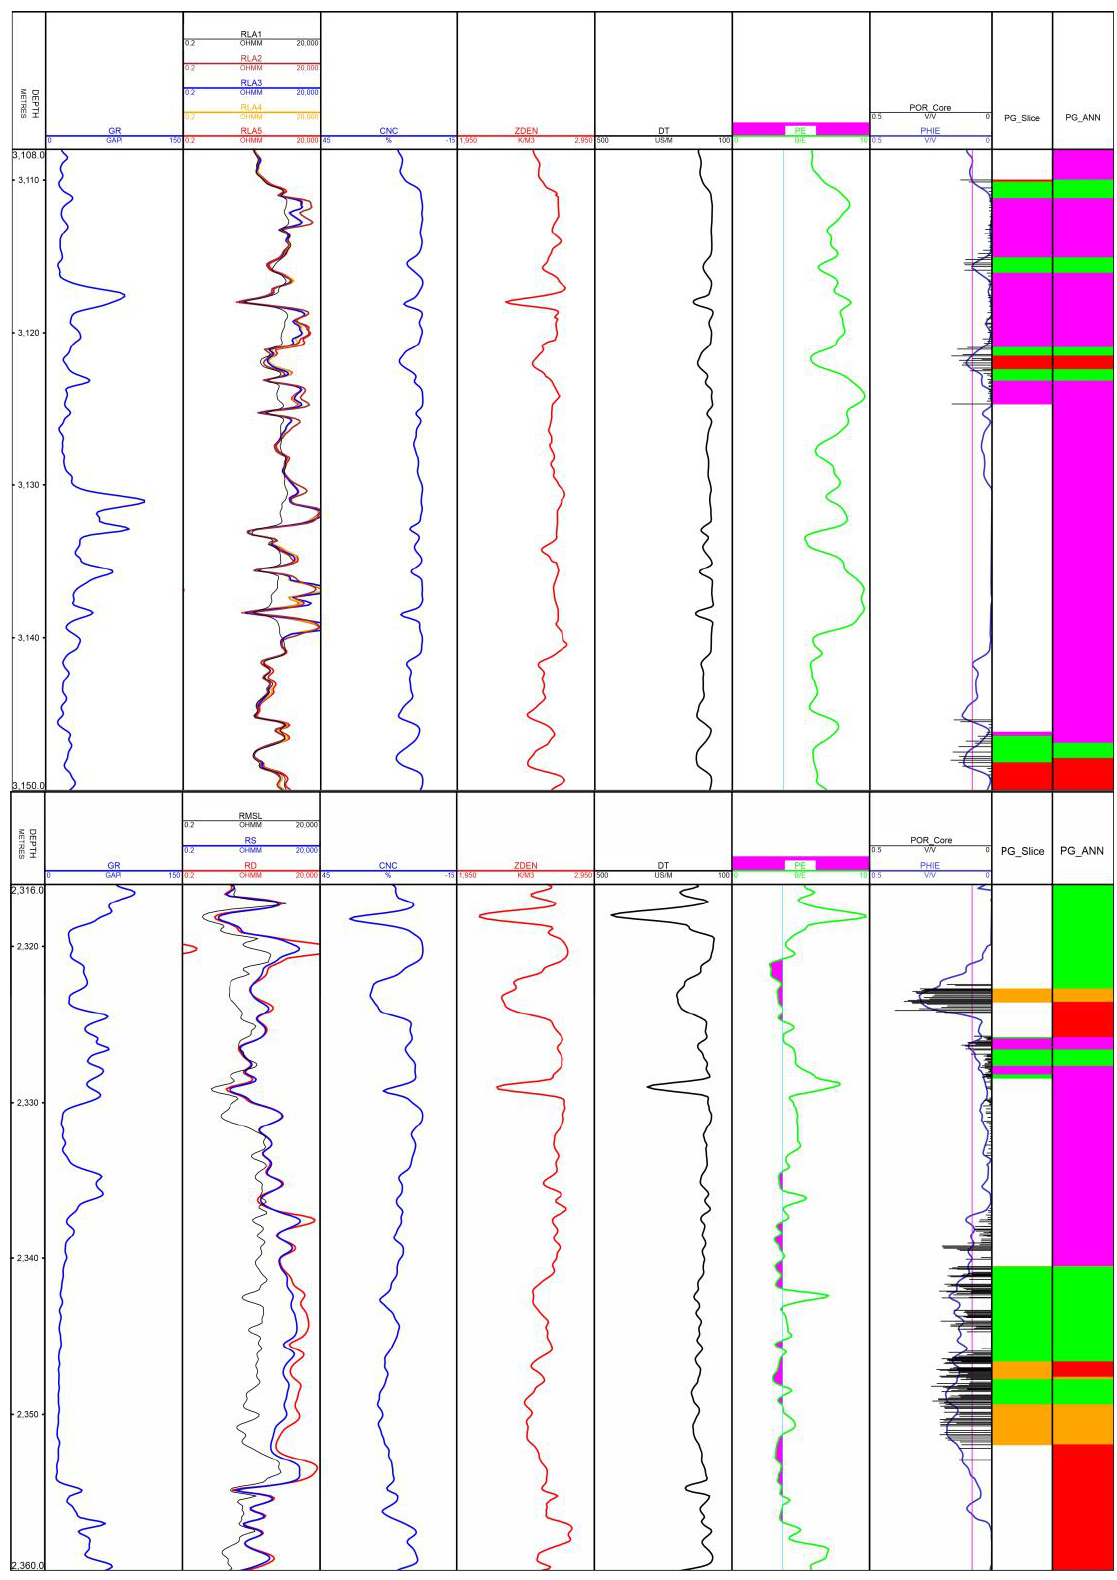
Figure 9. Results of petrophysical facies identification of Well CT-10 and CT-4 in North Truva Oil- field.